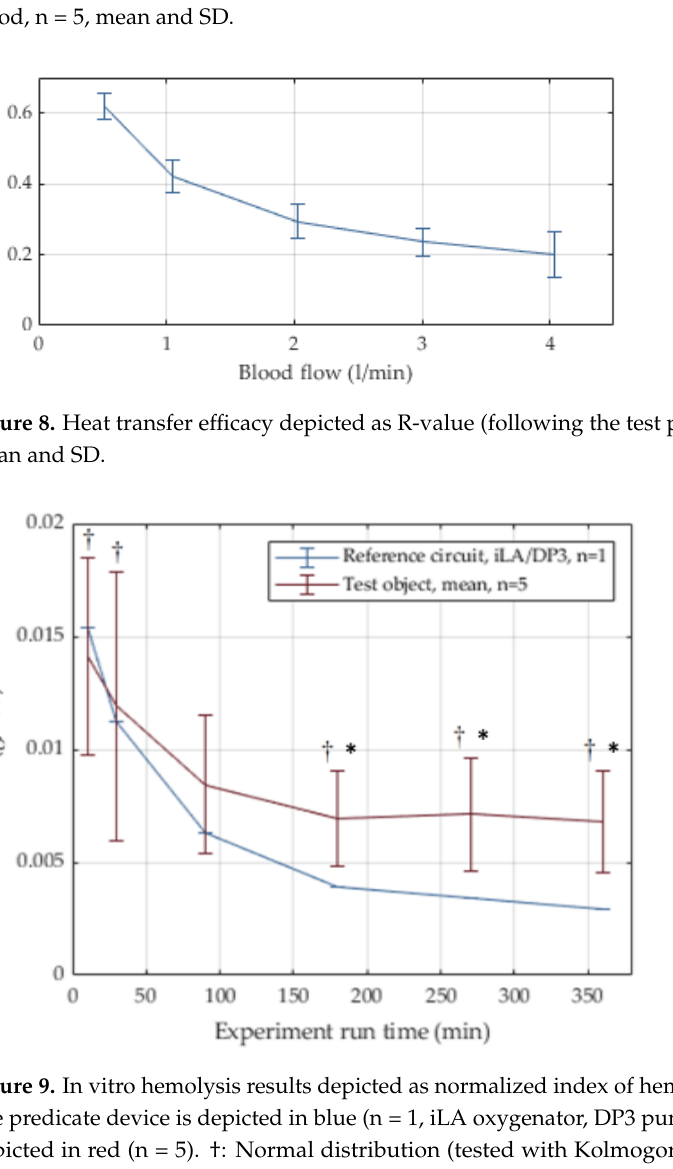
Figure 7. In vitro pressure drop in novel stacked membrane oxygenator using heparinized porcine blood, n = 5, mean and SD.